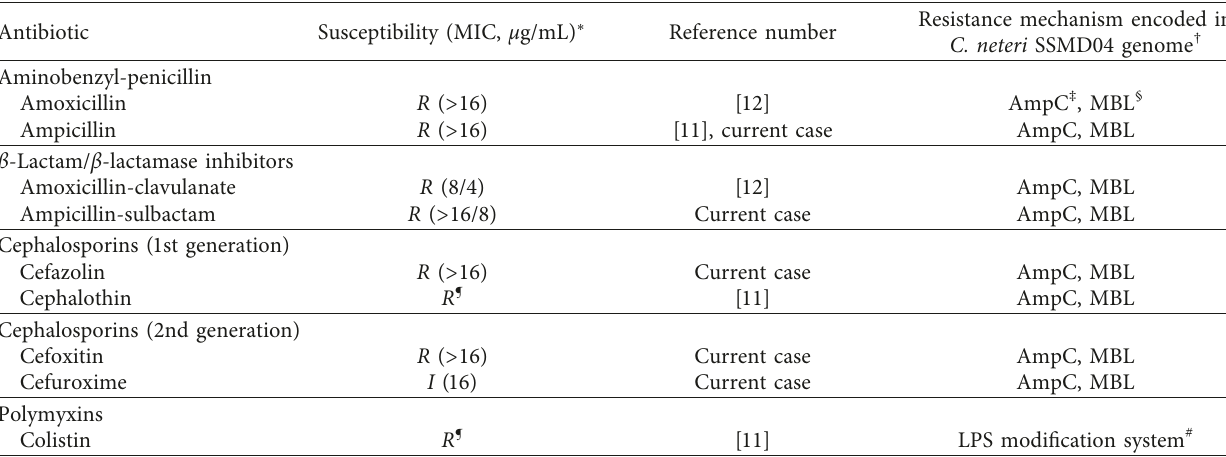
Table 2: Antibiotic resistance patterns of Cedecea neteri isolated from a patient’s catheter (current case) and reported in previous studies. Antibiotic